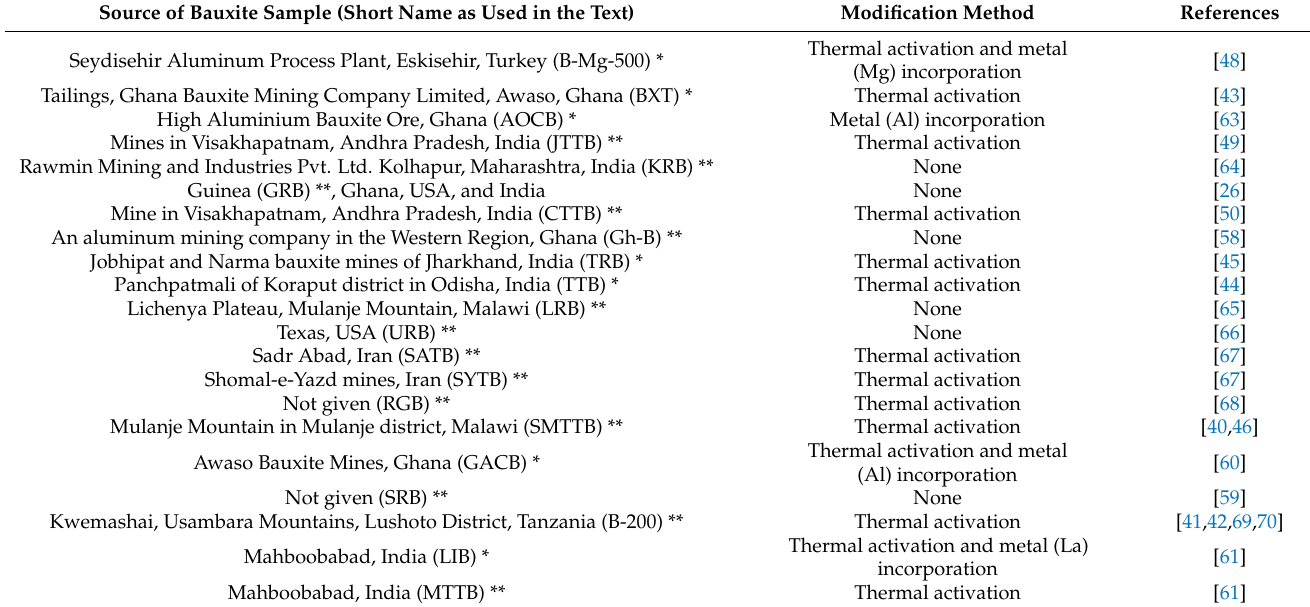
Table 3. Sources and pretreatment techniques of some bauxite samples applied in water defluoridation. Source of Bauxite Sample (Short Name as Used in the